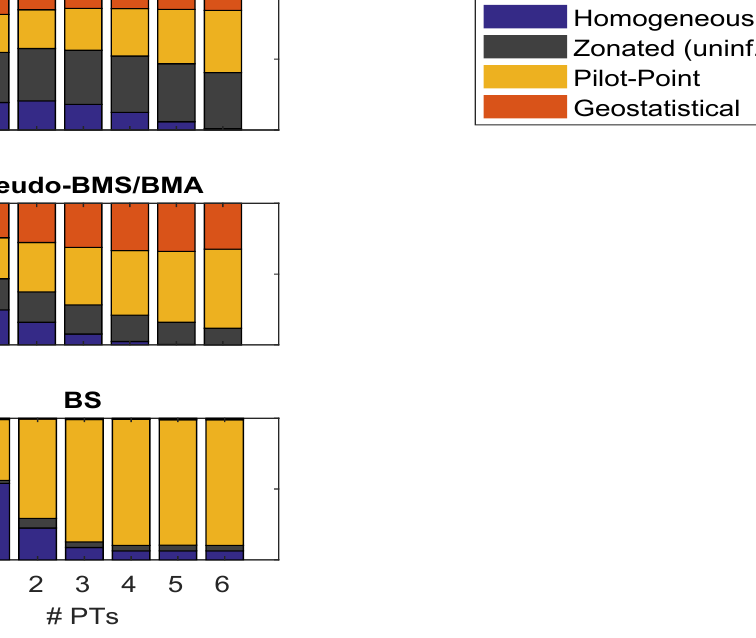
Figure 6. Expected model weights over growing data size (number of included pumping tests, # PTs) for the M -complete setting, i.e., with data observed from the sandbox aquifer. Top row: BMS/BMA; center row: Pseudo-BMS/BMA; bottom row: Bayesian Stacking